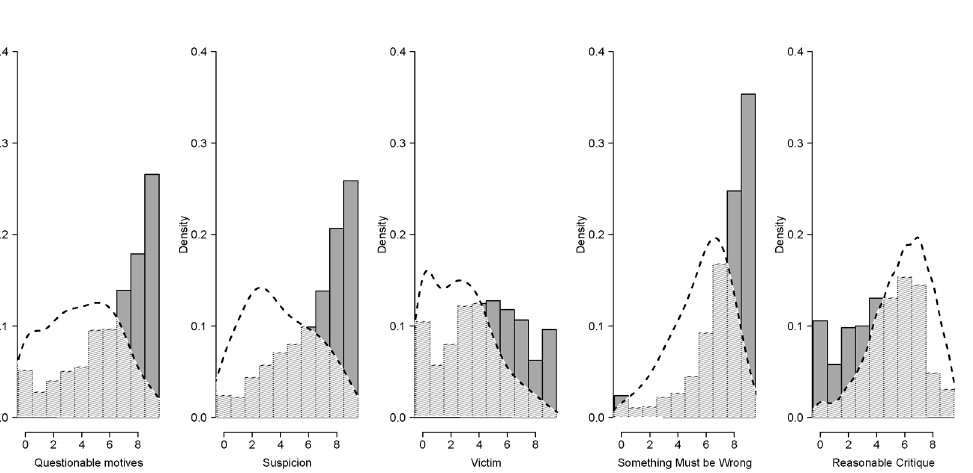
Figure 2. Histograms (dark gray) for all responses to web content (not averaged across trials within a participant) for all 5 questions in Study 3. The dashed line that encloses the cross-hatched area represents Gaussian kernel density estimates (using 1.5 times the standard bandwidth) of the equivalent responses to PhD-generated